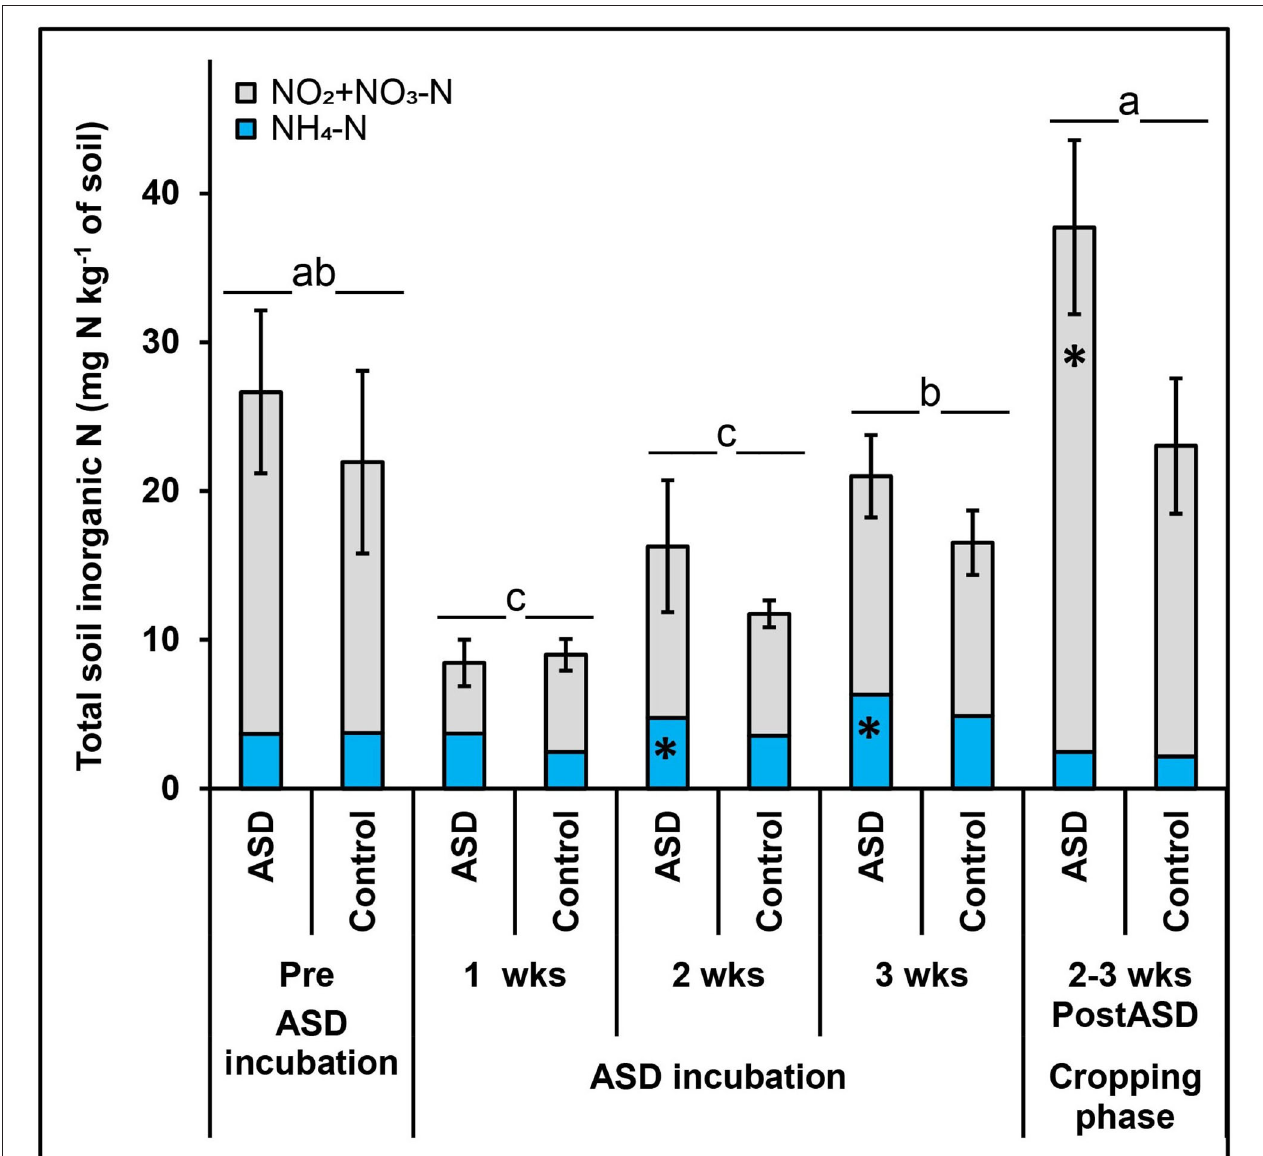
FIGURE 4 | Effect of ASD on soil inorganic N post-ASD treatment high tunnel study, trial 3. Bars indicated by similar letters for each category are not significantly different at P < 0.05 according to Fisher’s protected LSD test and means indicated by * are significantly different from the control. Error bars indicate standard error with twelve total replicates (6 replicates × 2 experiments). Control = anaerobic, compost-amended control.